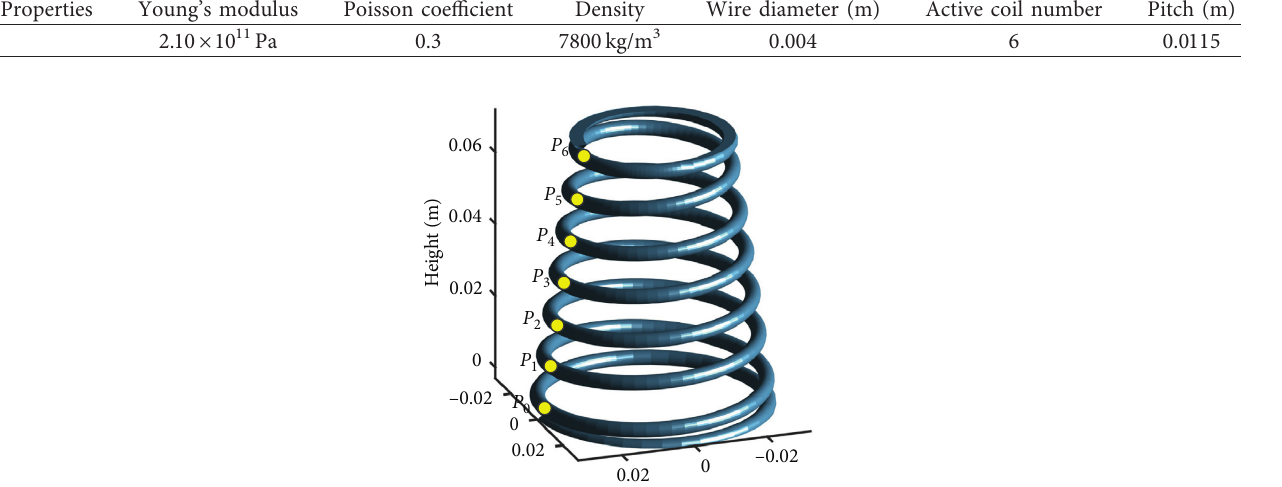
Figure 13: Model of a spring with variable radii.